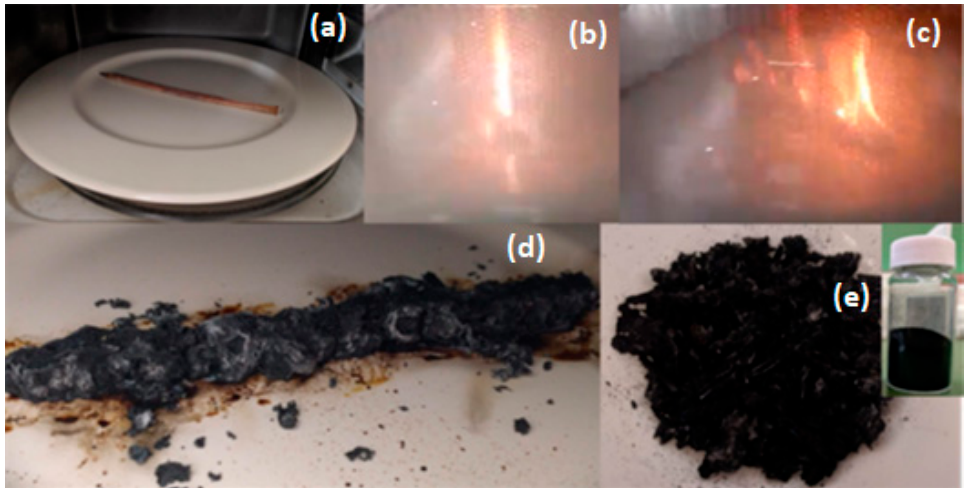
Figure 2. A wood pencil impregnated with KOH ( a ) was microwave irradiated as above ( b ). The graphite core produced hot plasma, igniting the pencil ( c ) and afforded a voluminous carbon mass around the graphite lead ( d ). The voluminous carbon was mechanically separated from the lead and worked up similarly as above to afford a fine carbon powder, codenamed APC (inset glass vial ( e )).